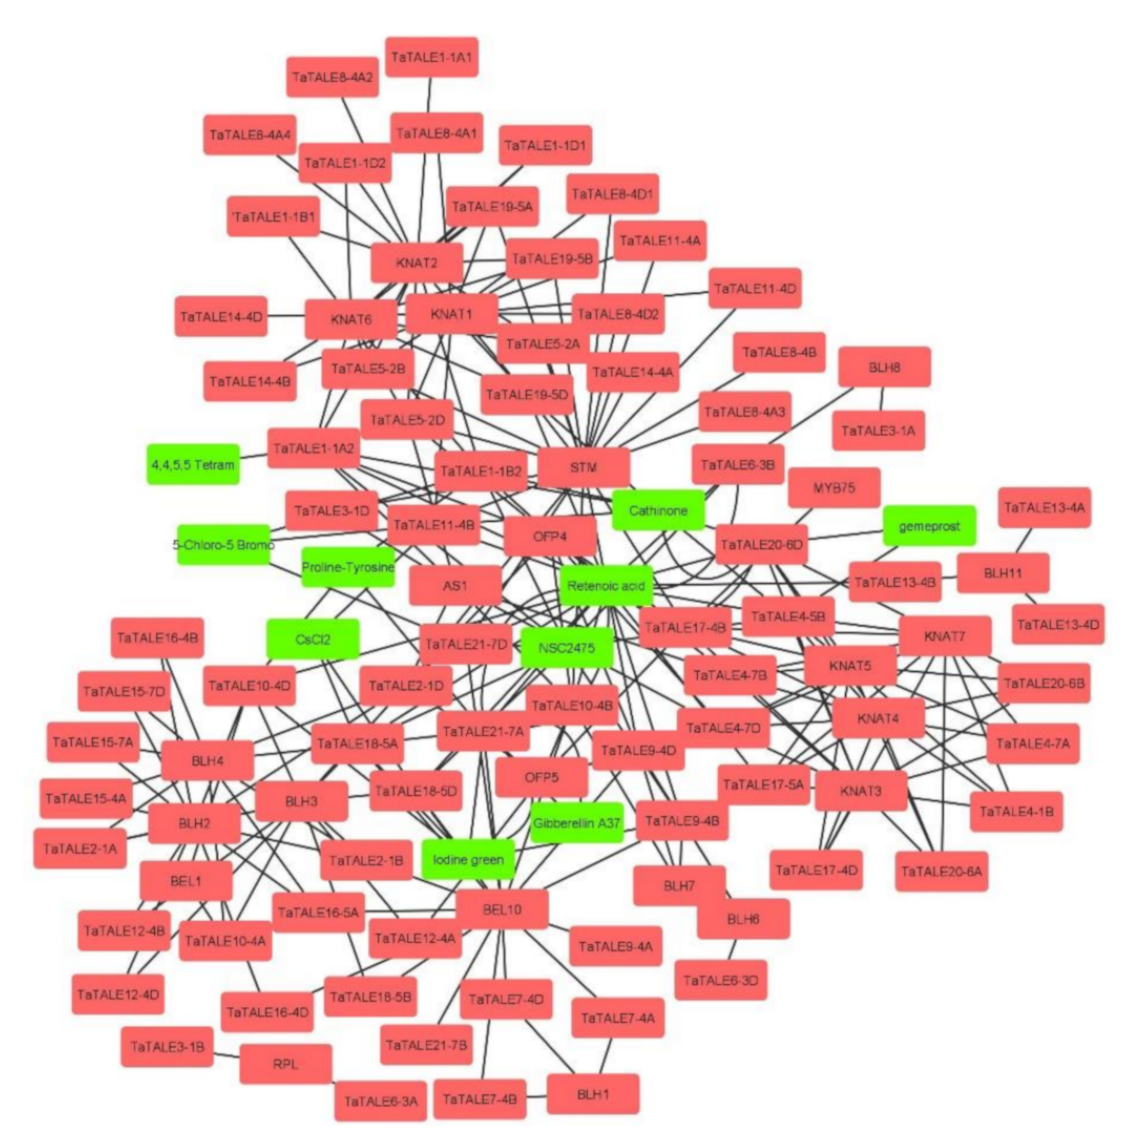
Figure 7. Interaction analysis of TaTALE proteins using the STRING and STITCH servers. The proteins are marked with pink color and metabolites are marked with green color. The interaction network was developed using the Cytoscape